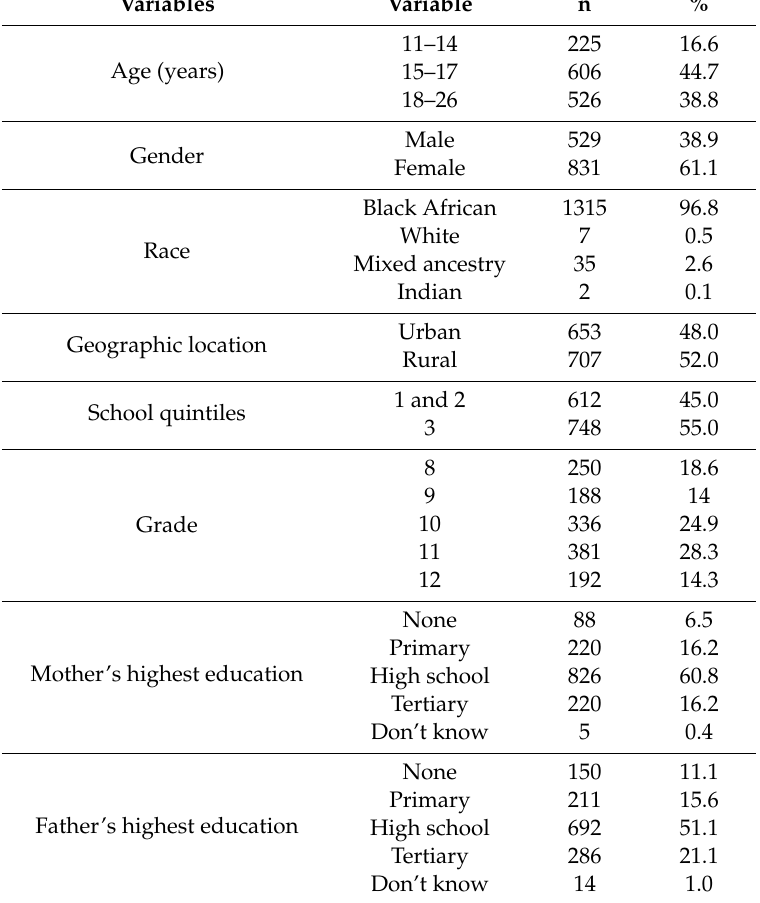
Table 1. Demographic characteristics of grade 8 to 12 learners from 16 secondary schools in the Eastern Cape (N =